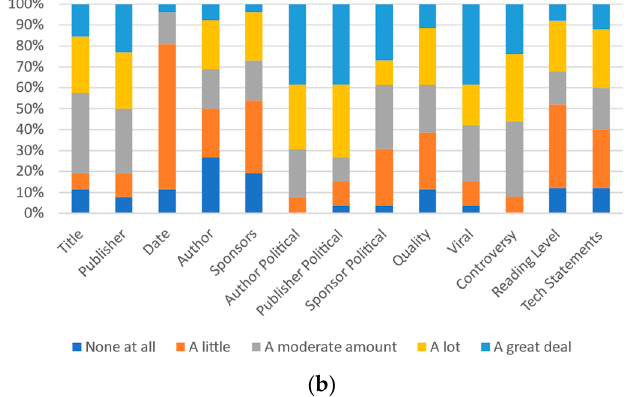
Figure 10. Participants’ responses on the magnitude of each category’s effect on most other people’s perception: ( a ) 18–29 and ( b ) 30+.